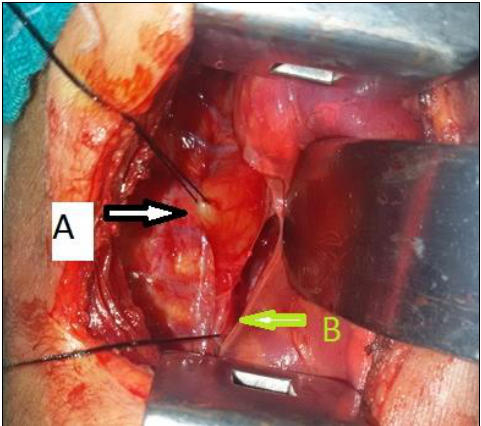
Figure 2: The operative photograph showing two ends of the esophagus (A-upper end and B- lower end) with intervening